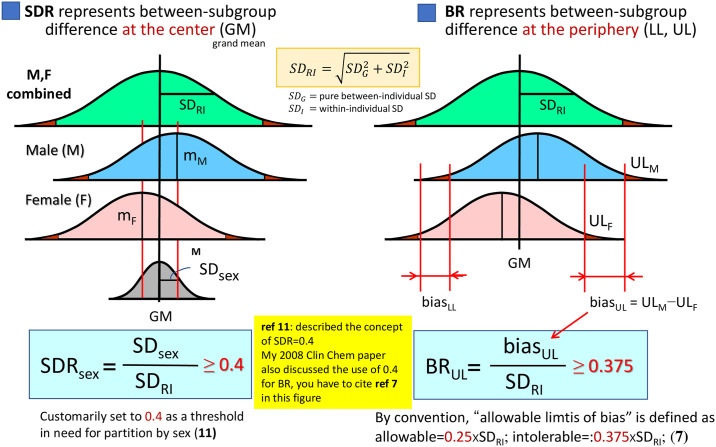
SD ratio (SDR) vs. bias ratio (BR) as a measure of between-subgroup differences.SDR represents between-subgroup differences at the center of distributions, while BR represents between-subgroup differences at the periphery (LL or UL) of the distributions. The numerator of SDR is between-subgroup SD (or SDsex, if sub-grouped by sex), while that of BR is a difference of LLs or ULs.